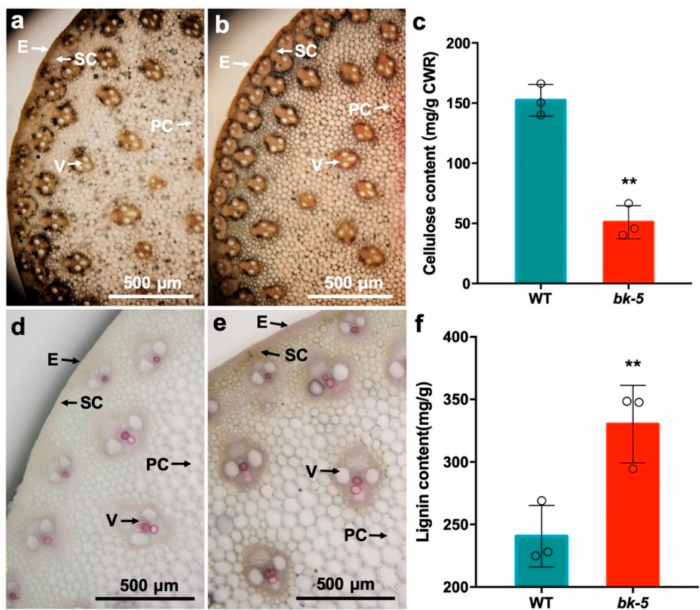
Figure 2. Histochemical staining and measurement of contents. ( a , b ) Staining of cellulose and hemicellulose of wild-type ( a ) stalk and bk-5 ( b ) stalk by zinc chloride iodide solution. The darker the color is, the higher the content of cellulose and hemicellulose is. ( c ) The content of cell wall cellulose of bk-5 and wild-type stalks. ( d , e ) Staining of lignin of wild-type ( d ) stalk and bk-5 ( e ) stalk by phloroglucinol solution. Pink represents the staining of lignin (the darker pink the color, the higher the content). E, epidermis; PC, parenchyma cells; SC, sclerenchyma cells; V, vascular bundle. ( f ) The content of cell wall lignin of bk-5 and wild-type stalks. All the samples were from the plants at jointing stage. The stalk uses the third internode above ground. The od circles represent the measured value of each group. The data were presented as values are given as means ± SD and statistically calculated by Student’s t -test. ** ( p < 0.01) indicate significant differences between RP125 and bk-5 . Three biological repetitions each group were